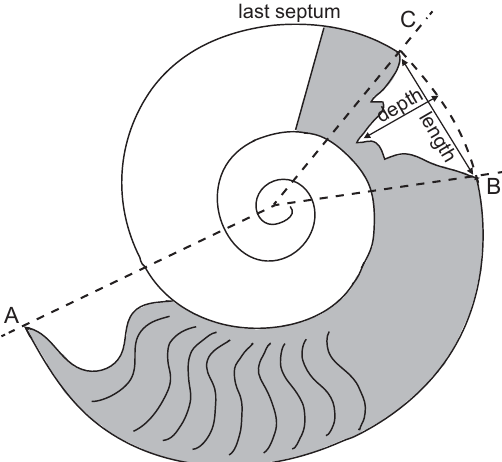
Fig. 3. Measurements for analysing the ventral breakage of ammonoid shells. Lines A, B, and C are the reference lines: A, from the coiling centre to aperture; B, apertural marginal line of damage; C, adapical marginal line of damage. Shaded area indicates body chamber. The length and depth of the breakage were also